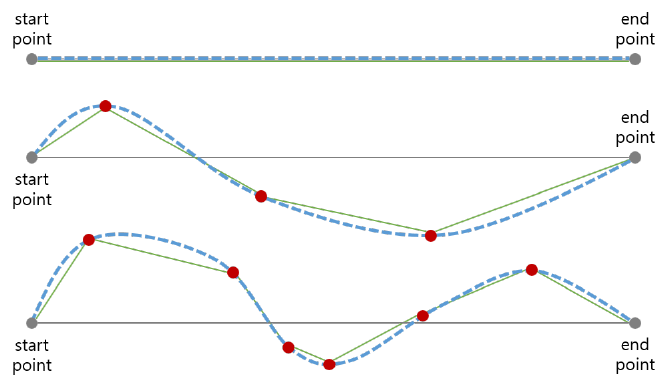
Figure 6. Segmentation of input trajectories (blue) with local extremes and inflection points